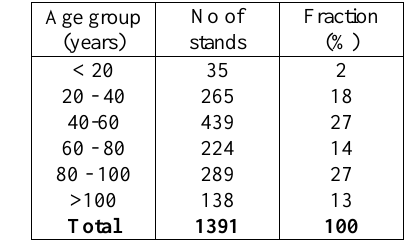
Table 2 . Spruce stands as a dominant species by age.